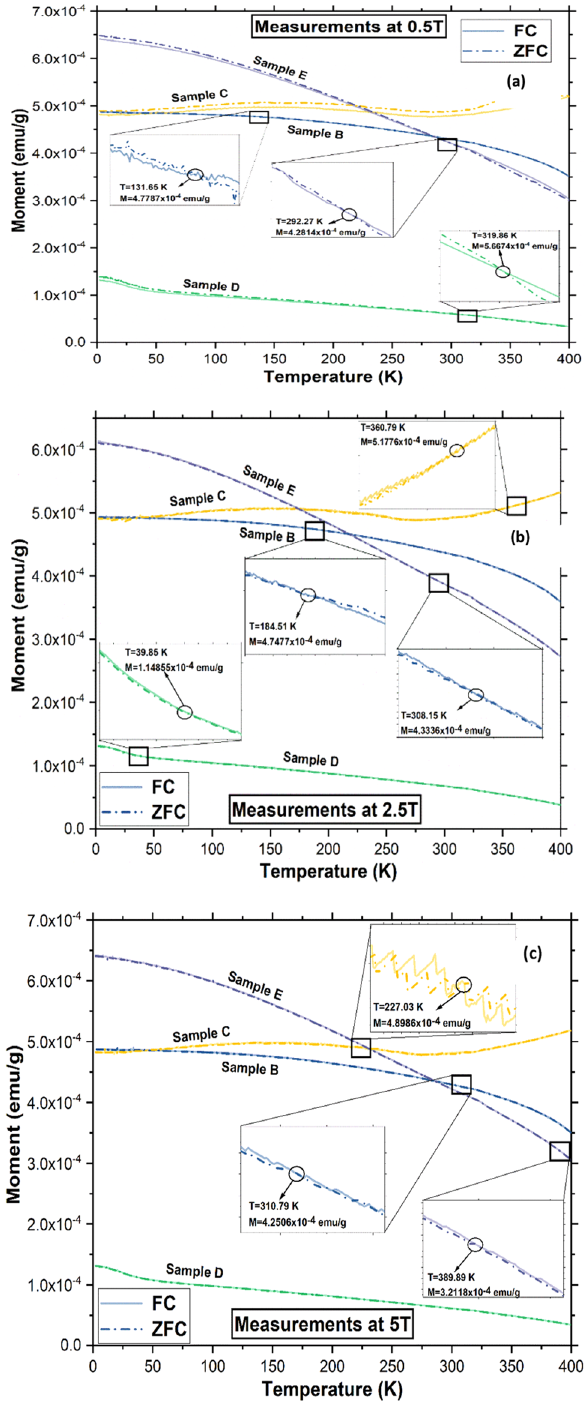
Figure 5. Field cooled (FC) and zero field cooled (ZFC) response for SHMNP composite samples B, C, D and E at ( a ) 0.5 T, ( b ) 2.5 T, and ( c ) 5